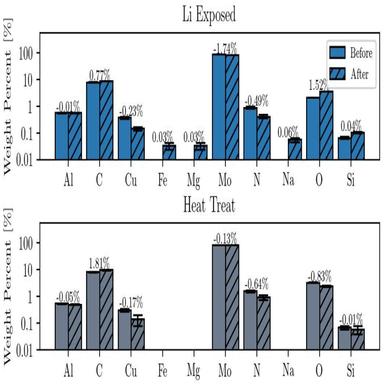
EDS of the molybdenum sample, showing average quantitative surface composition obtained from EDS analysis at 10000X magnification for all lithiumexposed samples (blue) and heat-treated sample (gray). Like the tungsten, the molybdenum seemed to pick up stainless-steel components from the canister. Oxygen is also present on the surface after lithium exposure, with a slight decrease in molybdenum. Error bars represent the standard deviation in composition and the numbers above the bars give the change in aver